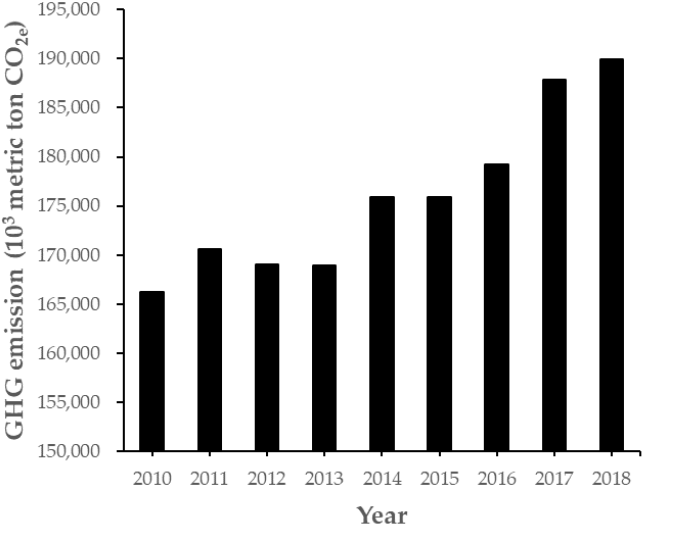
Figure 2. Variations in Taiwan’s GHG emissions from the energy industries during the period of 2010–2018 [18]. Table 2. Taiwan’s GHG emissions from the energy industries in terms of GHG sources since 2010 1 . Table 1. Taiwan’s GHG emissions from the energy industries in terms of categories of GHG since 2010 1 . GHG Category